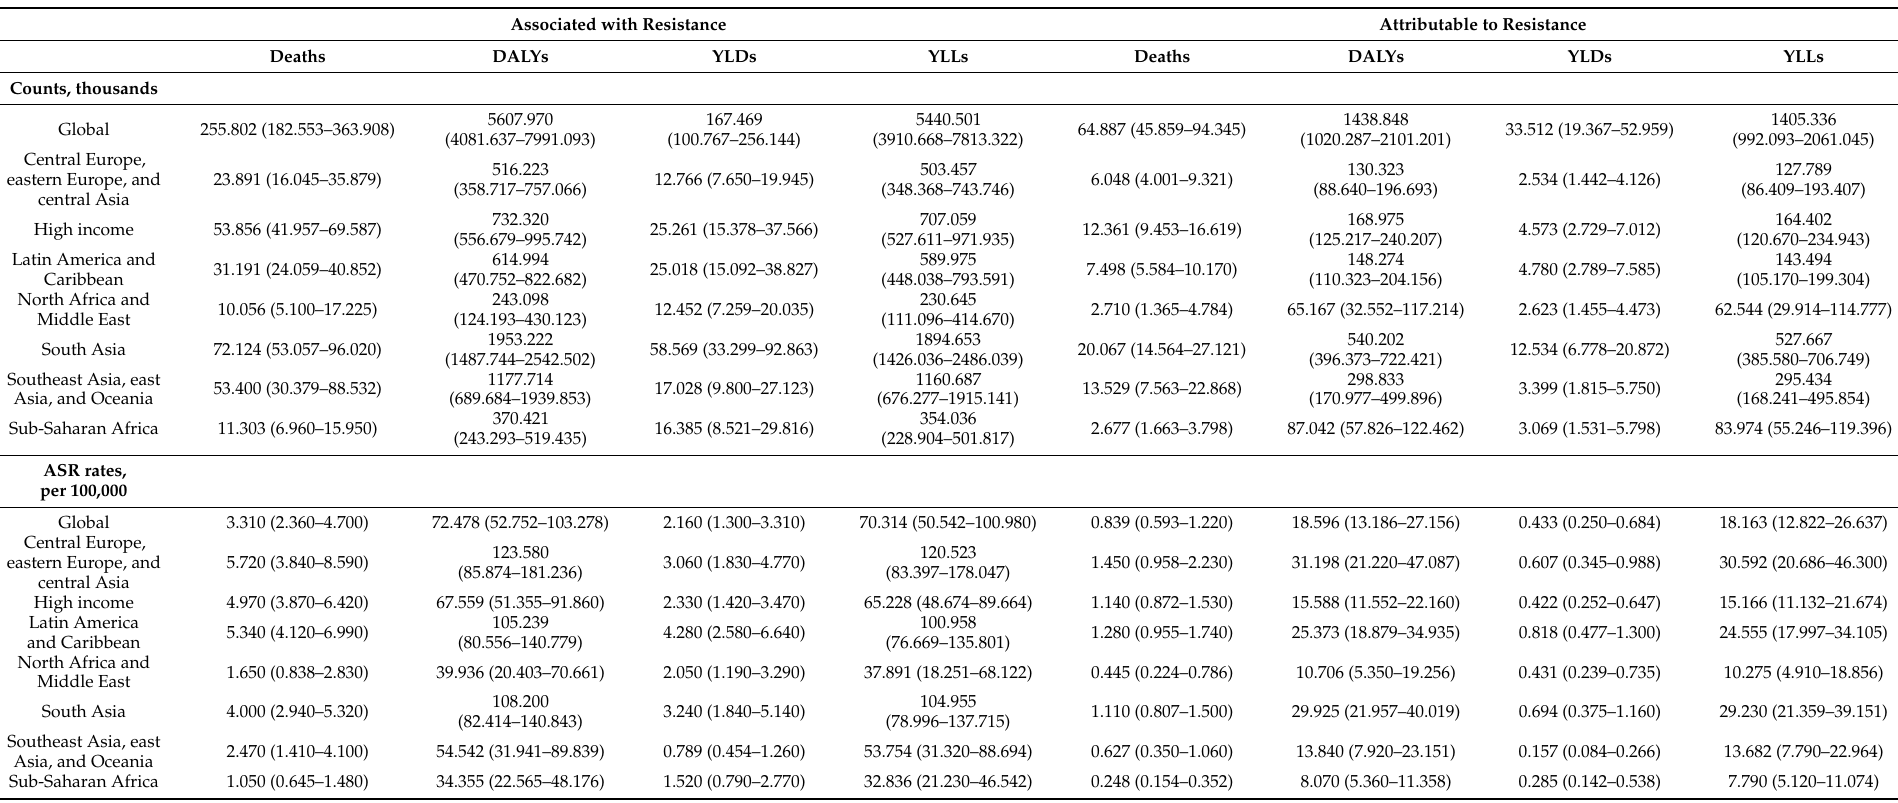
Table 1. Deaths, DALYs, YLDs, and YLLs (in counts and all-age rates) associated with and attributable to bacterial AMR in UTI, globally and by GBD super-region,